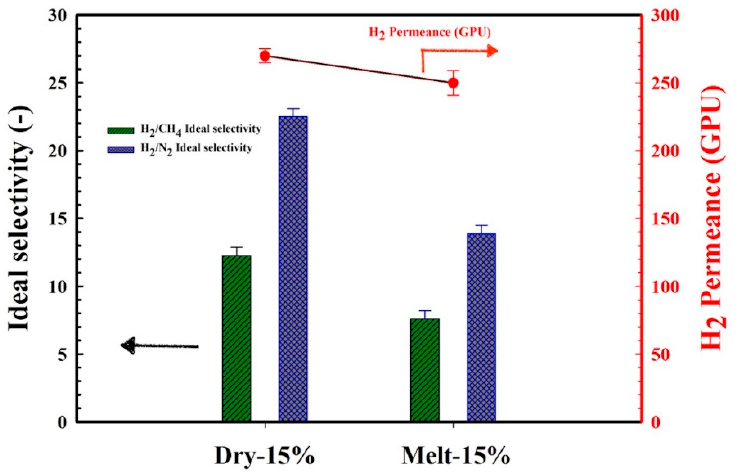
Figure 14. Effect of melt compounding and dry blending on H 2 /CH 4 and H 2 /N 2 ideal selectivity and H 2 permeance of the selected MMFM15 membranes with 15 wt % zeolite.